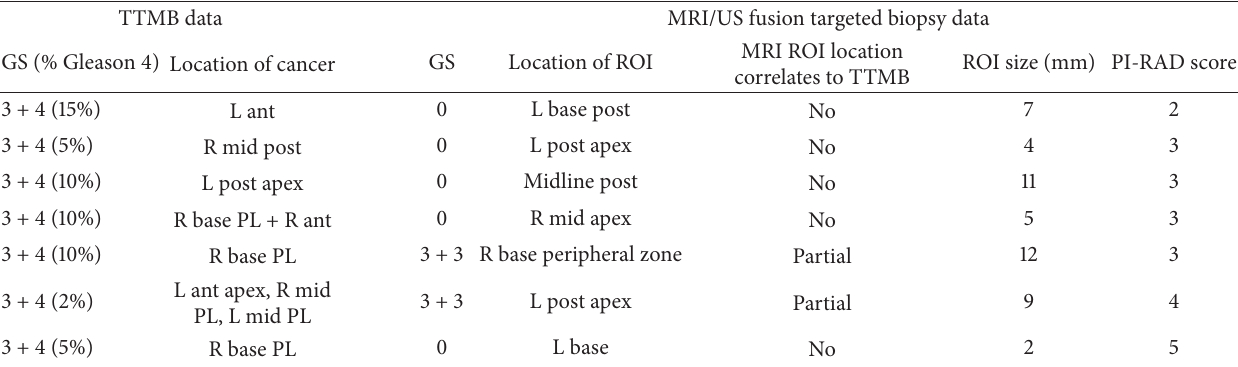
Table 6: Missed cancers (cancers detected on TTMB but missed on MRI targeted biopsy: significant upgrades only). TTMB data